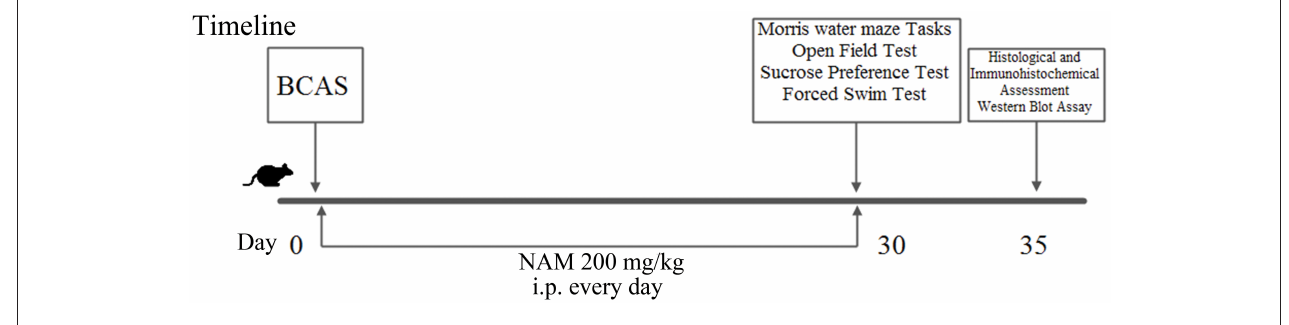
FIGURE 1 | Scheme showing the experimental design of the study.